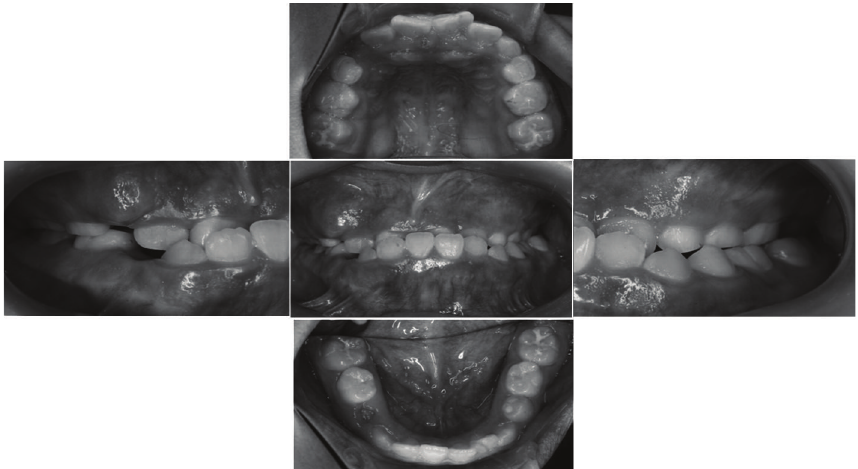
Figure 1: Intraoral photographs at the first visit of this patient.